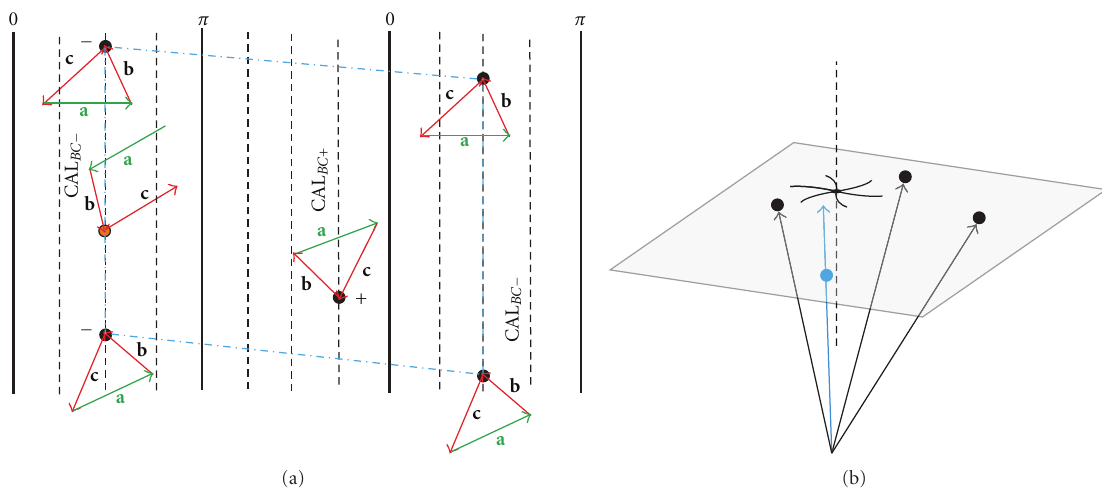
Figure 3: (a) A set of CALs (dashed lines) of two interfering waves B and C . By adding the third wave—wave A —a regular vortex lattice is generated. The arrows a , b , and c are phasors of wave A , B , and C , respectively. The OVs appear at points where the three phasors form a triangle. The whole pattern can be divided into two subsequently appearing regions: the region with positive vortices and the region with negative vortices, respectively. The CALs BC representing angle value 0 and π (bold lines) are borders between these two regions. Vortex points are marked by black dots. The four neighboring vortices of the same topological charge form an equilateral basic cell (dash dotted blue line). (b) The ends of three non-collinear wave vectors define the OVI plane. The optical vortex generated by the three-plane waves moves along the straight line (dashed line) perpendicular to the OVI plane. When adding one more wavevector (blue in this Figure) the OVI plane cannot be defined, but in very specific